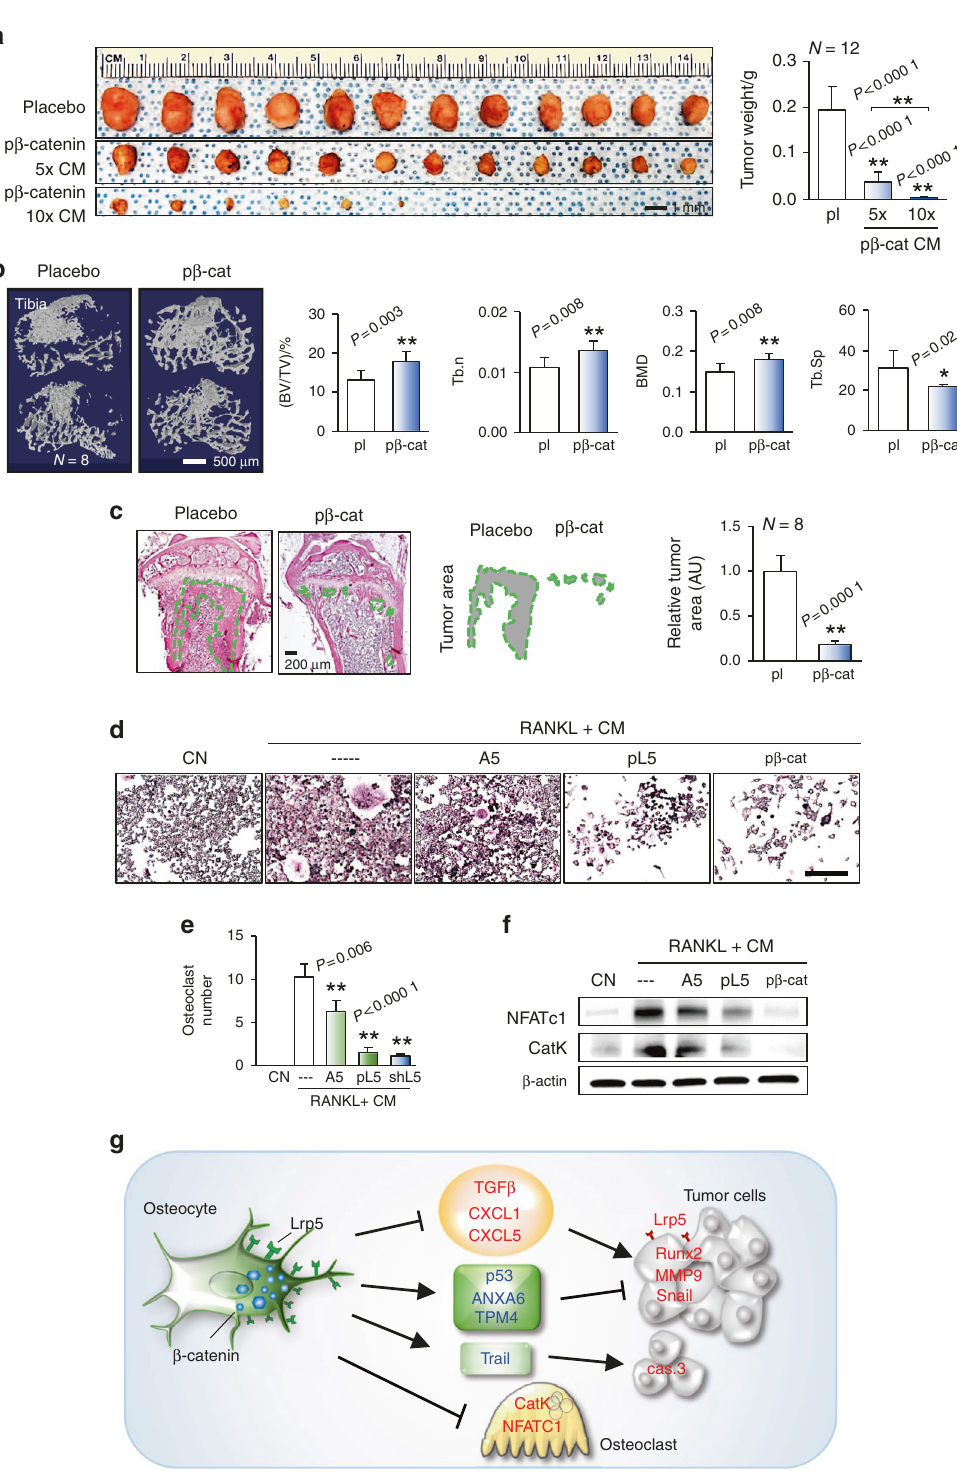
Fig. 6 Effects of β -catenin-linked Wnt signaling in A5 osteocytes on tumor progression. CN control (plain medium), CM conditioned medium, pl placebo, pL5 Lrp5 plasmids, and p β -cat β -catenin plasmids. The single and double asterisks indicate P < 0.05 and P < 0.01, respectively. a – c Signi fi cant reductions in mammary tumor growth and bone degradation in the tibia in C57BL/6 mice by systemic administration of β -catenin-overexpressing osteocyte-derived CM. d – f Signi fi cant reductions in the number of TRAP-stained mature osteoclasts and the expression of NFATc1 and Cathepsin K in RANKL-stimulated osteoclasts by treatment with Lrp5- and β -catenin-overexpressing osteocyte- derived CM. Scale bar: 200 μ m. g Schematic illustration of the mechanism regulating tumor-osteocyte interactions. In this diagram, Lrp5 and β -catenin in osteocytes inhibit tumor progression by decreasing the expression of tumor-promoting genes (TGF β , CXCL1, and CXCL5) and increasing the expression of tumor-suppressing genes (p53, ANXA6, and TPM4) and apoptosis-inducing genes (Trail). In tumor cells, tumor- promoting genes (Lrp5, Runx2, MMP9, and Snail) were downregulated. Overexpression of Lrp5 and β -catenin also inhibited osteoclastogenesis by downregulating NFATc1 and cathepsin